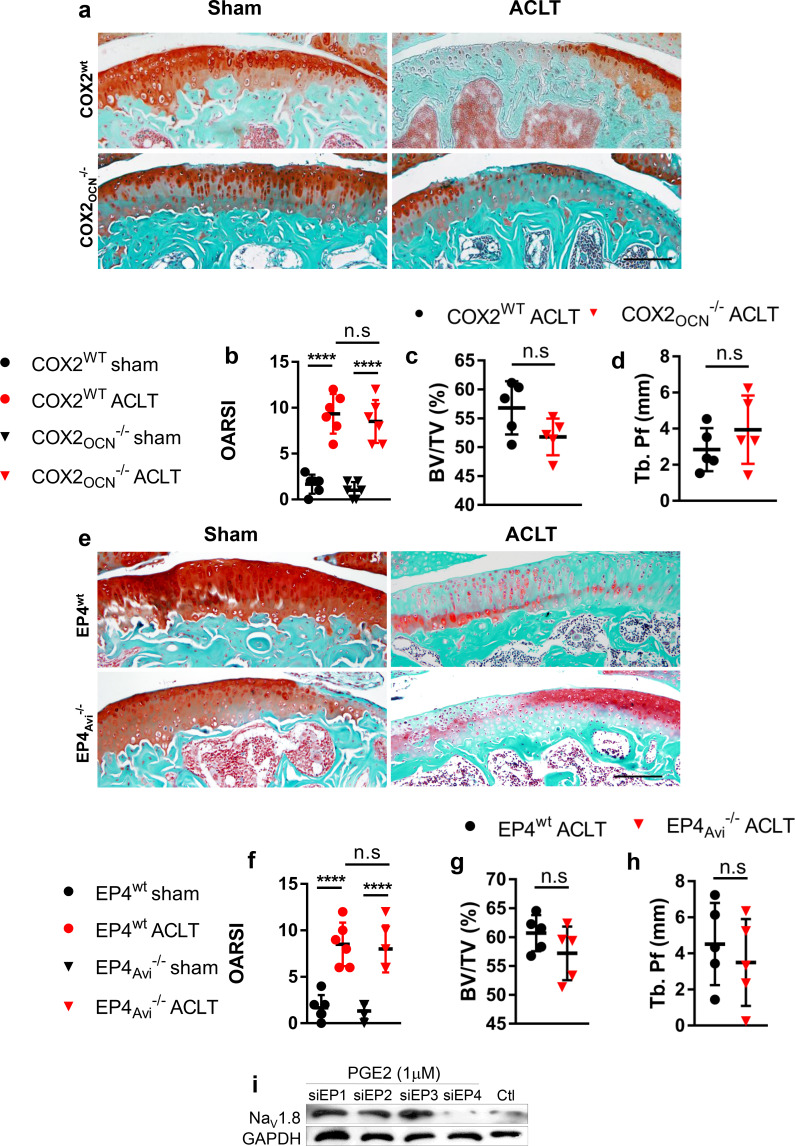
Subchondral bone remodeling in Cox2:OCN cKO and EP4:Avil cKO mice after ACLT.(a, b) Representative photos of knee joint Safranin Orange and fast green staining (a) and statistical analysis (b) in Bglap-Cre::Cox2fl/fl or Cox2fl/f mice 4 weeks after sham or ACLT surgery at 1 m. Scale bars, 500 μm. (c, d) Statistical analysis of BV/TV (c) and Tb. Pf (d) in Bglap-Cre::Cox2fl/f mice 4 weeks after sham or ACLT surgery at 1 m. n = 6 per group. (e, f) Representative photos of knee joint Safranin Orange and fast green staining (e) and statistical analysis (f) in Avil-Cre::Ptger4fl/fl or Ptger4fl/fl mice 4 weeks after sham or ACLT surgery at 1 m. Scale bars, 500 μm. (g, h) Statistical analysis of BV/TV (g) and Tb. Pf (h) in Ptger4Avi-/- mice 4 weeks after sham or ACLT surgery at 1 m. n = 6 per group. (i) western blot of EPs knockdown on the effect of Nav1.8 upregulation after PGE2 stimulation in DRG. *p<0.01, ***p<0.001, ****p<0.0001 compared with the sham-operated group or healthy donors at different time points. Statistical significance was determined by unpaired Student’s t test (b, c, d, f, g and h), and all data are shown as scattered plots with means ± standard deviations.Figure 2—figure supplement 1—source data 1.Full scan of western blots in Figure 2—figure supplement 1i.